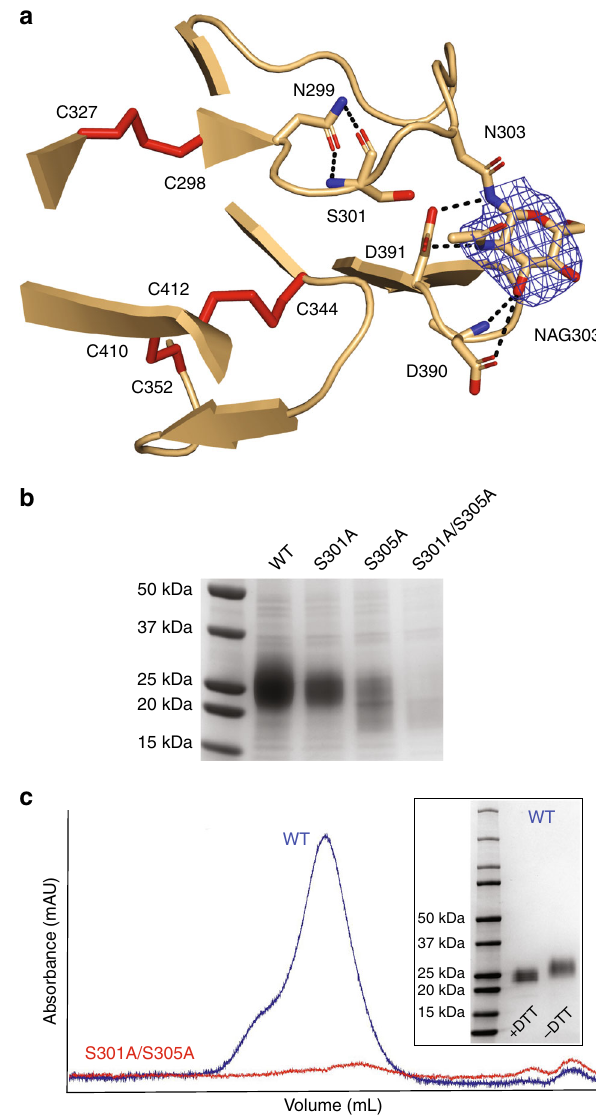
Fig. 3 N-linked glycosylation improves expression of monodisperse Pfs48/ 45 6C. a The NAG at position N303 mediates H-bonds with D390 and D391, and helps stabilize the two loops that connect strands a – a ′ and strands e – f in the proximity of the three disul fi de bonds (red sticks). The blue mesh is the composite omit electron density map rendered at a 1.2 σ contour level around the N303 NAG residue. b SDS-PAGE under reducing conditions and stained with Coomassie Blue for recovered samples from Ni-NTA af fi nity chromatography with Pfs48/45 6C constructs of varying N-linked glycan content. c Size-exclusion chromatograms comparing the recovery and monodispersity of Pfs48/45 6C constructs that lack both (red), or no (blue) putative N-linked glycosylation sites. The inset is an SDS-PAGE gel stained with Coomassie Blue showing the purity of the monomeric, glycosylated Pfs48/45 6C